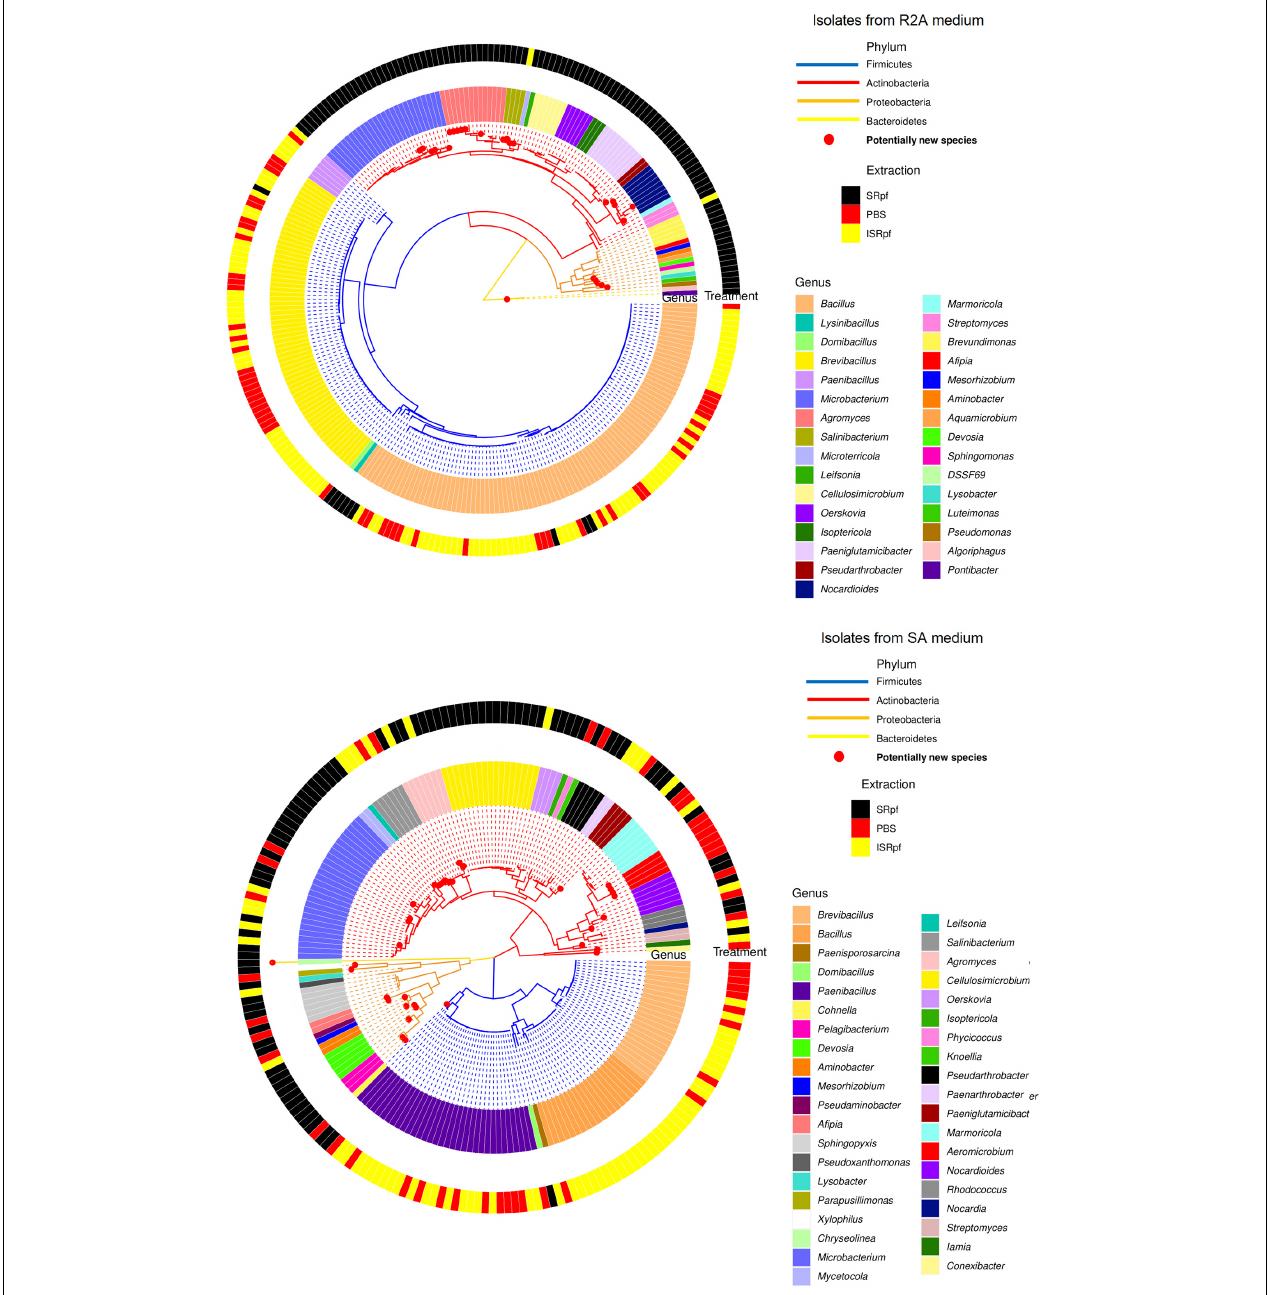
FIGURE 8 | Isolate-based phylogenetic tree of community cultured on R2A medium (upper panel, 274 isolates) and SA medium (lower panel, 206 isolates). Genera are read clockwise starting at